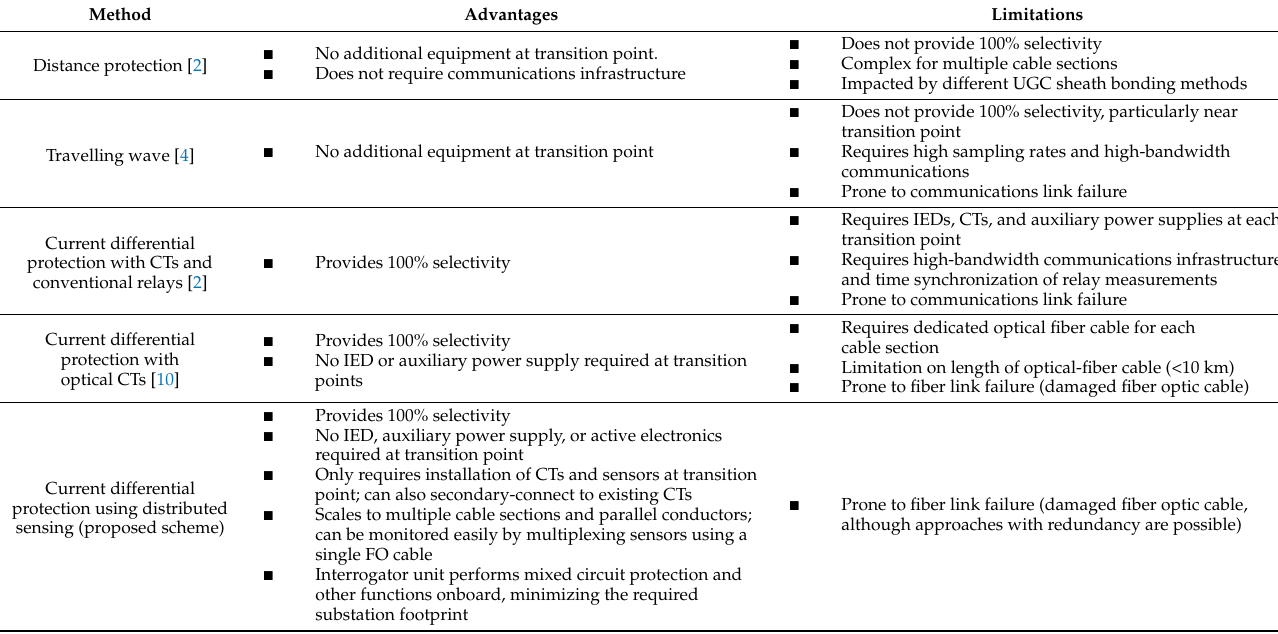
Table 3. Comparison of the proposed scheme with other mixed conductor circuit protection methods. Method Advantages